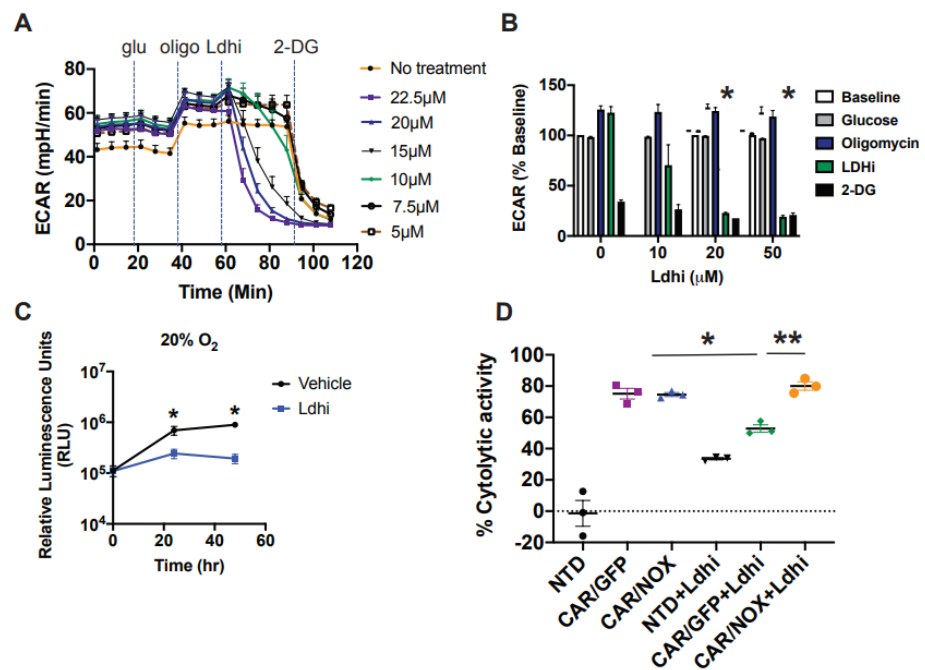
Figure 4. Lactobacillus brevis NADH Oxidase ( LbNOX ) rescues CAR T-cell cytotoxicity in cultures treated following Lactate Dehydrogenase (LDH) inhibition. ( A , B ) The metabolic properties of EM-meso cells were measured by a Seahorse assay. Extracellular acidification rates (ECAR) following the serial addition of 20 mM glucose, 1.5 uM oligomycin, Ldhi, and 20 mM 2-DG are shown in a representative Seahorse plot (left panel). Inhibiting LDH (Ldhi) reduces EM-meso cell glycolytic activity in a dose-dependent manner. Mean ± SEM values from multiple independent experiments with separate donors ( n = 2–3) are shown (right panel). Ldhi ECAR values were measured 33 min following Ldhi injection and 20 µ M Ldhi significantly reduced glycolytic activity relative to vehicle control (* p < 0.05). Statistical comparisons were compared using an unpaired Student’s t test. ( C ) EM-meso-CBG cells were seeded in triplicate in 96-well plates and treated with either the vehicle or 20 µ M Ldhi. Their growth was measured by a luminescent assay. The mean ± S.E.M. values of 3 independent experiments are shown. * p < 0.05 for Ldhi vs. the vehicle at 24 h and 48 h. ( D ) The specific cytotoxicity of anti-mesothelin CAR T-cells was measured by luciferase-based killing assay. CAR T-cells were co-cultured with EM-meso cells at a 3:1 effector: target cell ratio for 22 h in medium conditioned with 20 µ M Ldhi. The mean ± S.E.M. values of 3 independent experiments with separate donors are shown. * p < 0.05 for CAR/GFP vs. CAR/GFP+Ldhi; ** p < 0.05 for CAR/GFP+Ldhi vs. CAR/NOX+Ldhi. Data were analyzed by a two-way ANOVA using a Newman–Keuls multiple comparison post hoc